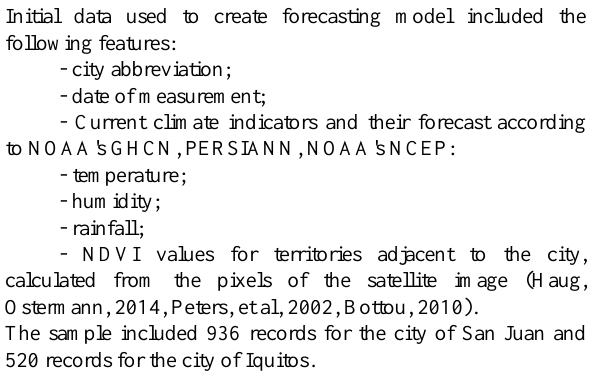
Figure 3. Relative humidity, percentages